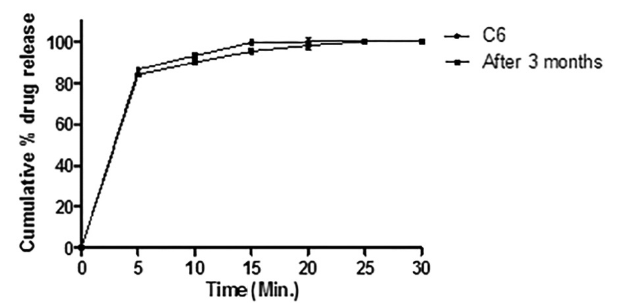
FIGURE 4 - In vitro drug release study of granisetron hydrochloride from ODT tablets before and after 3